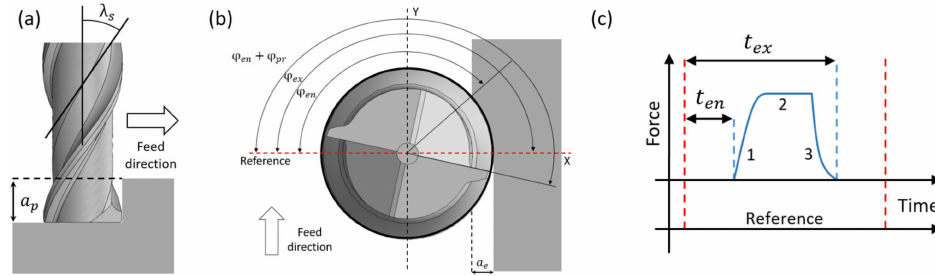
Figure 8. Main parameters of the milling process. ( a ) Side view, ( b ) top view and ( c ) cutting force evolution during the machining